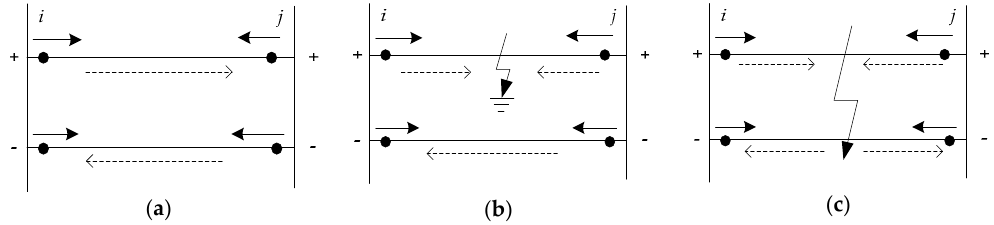
Figure 5. Fault ‐ type diagram: ( a ) Normal operation; ( b ) Pole ‐ to ‐ ground short ‐ circuit short ‐ circuit fault; ( c ) Pole ‐ to ‐ pole short ‐ circuit fault.